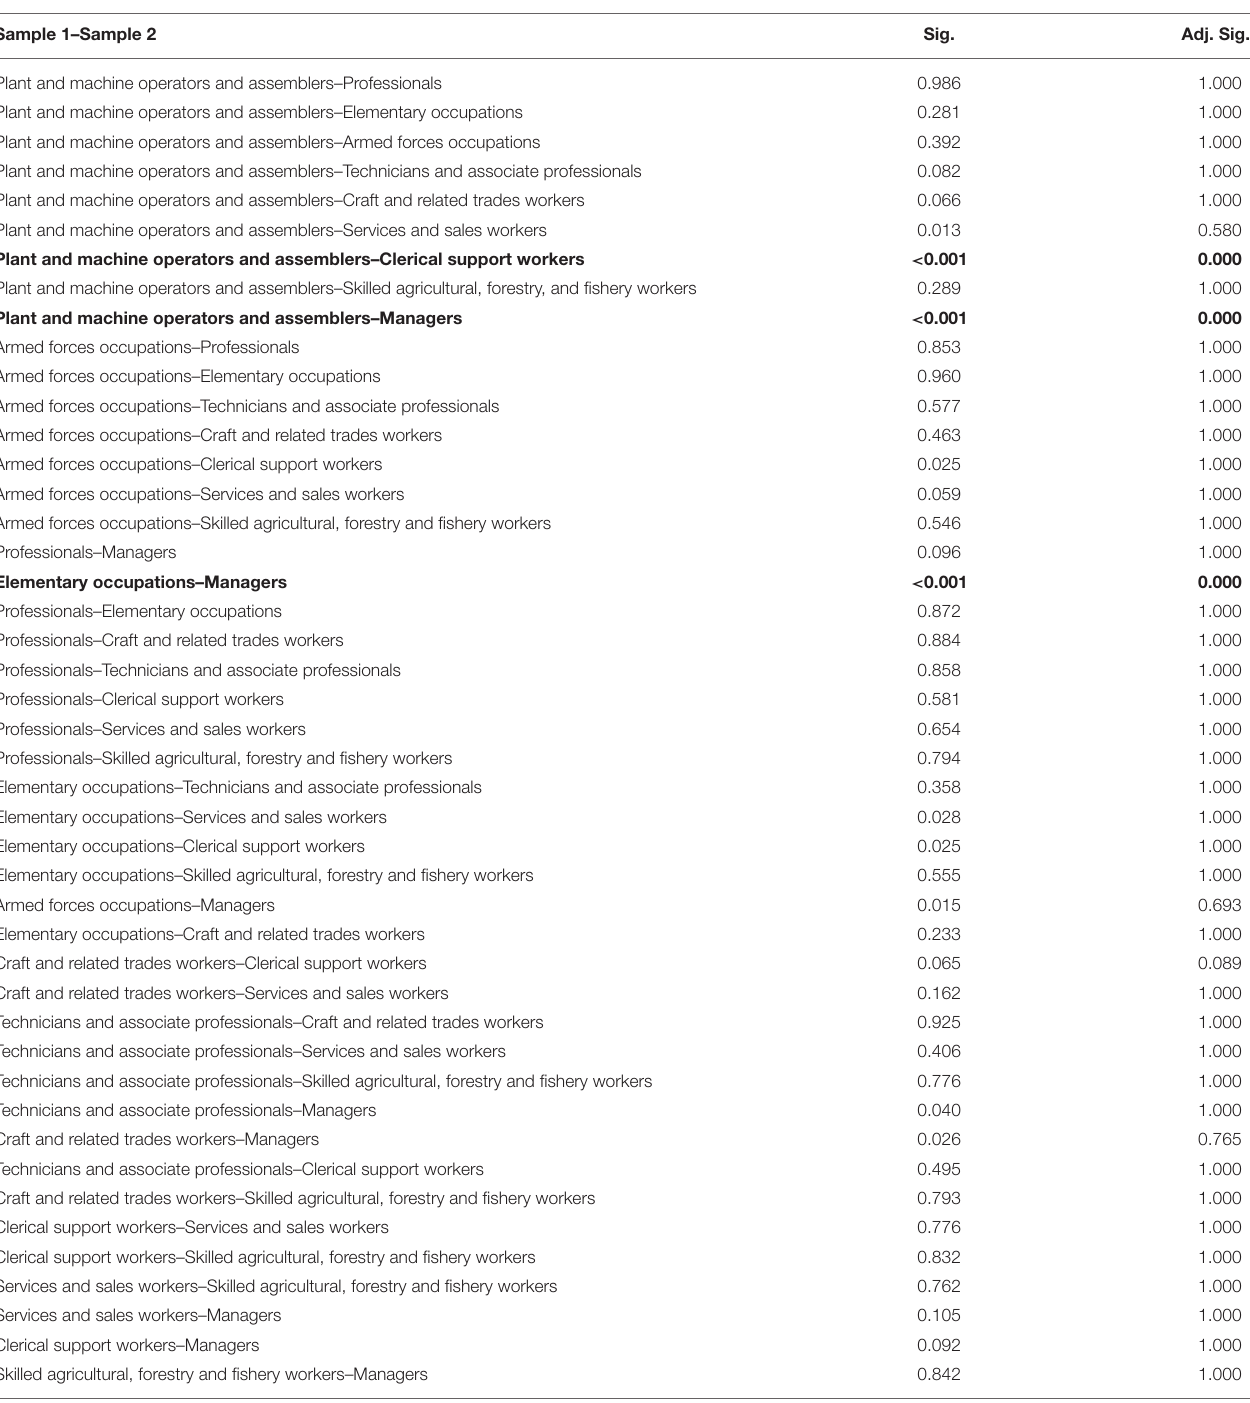
TABLE 6 | Pairwise comparisons: the average length of sick leave in the study sample of young adults aged 15–29 years, according to International Statistical Classification of Diseases and Related Health Problems, version 10, the Czech Republic, 2017. Sample 1–Sample